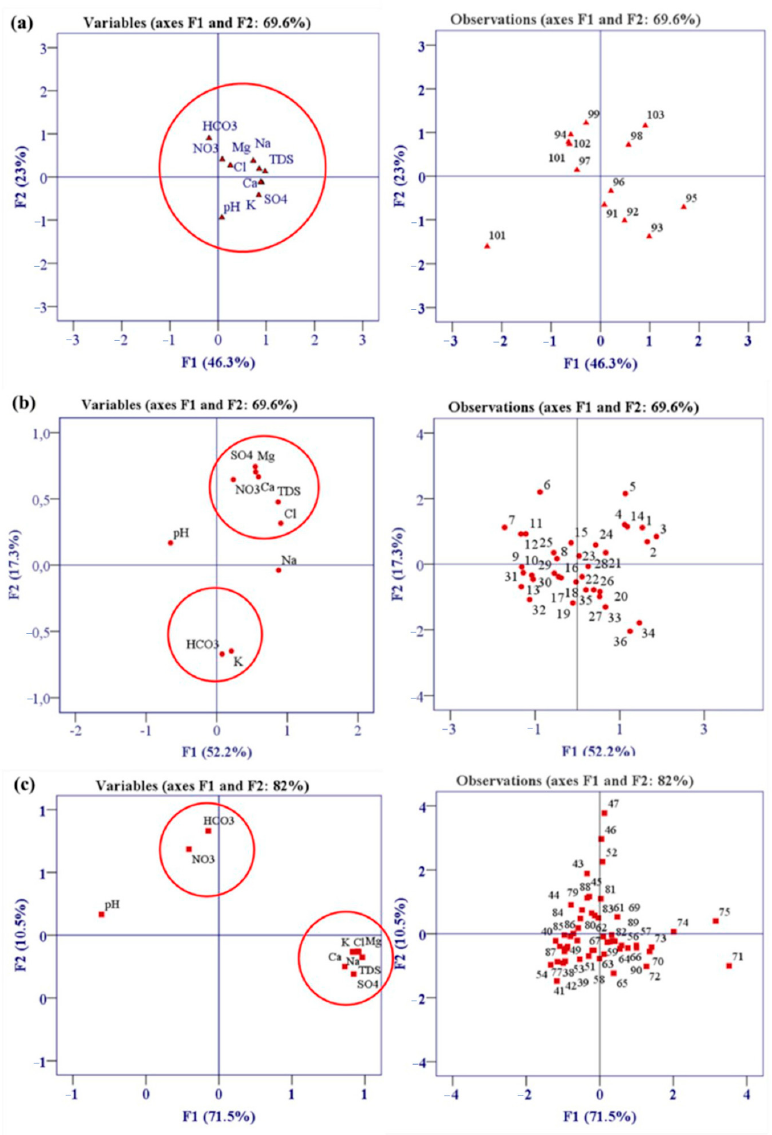
Figure 7. Projection of observations and variables into the factorial plane (F1 × F2): ( a ) sub-basin of Awled Asker (13 samples), ( b ) sub-basin of Oued El Hjal (36 samples), and ( c ) sub-basin of Sidi Bouzid (57